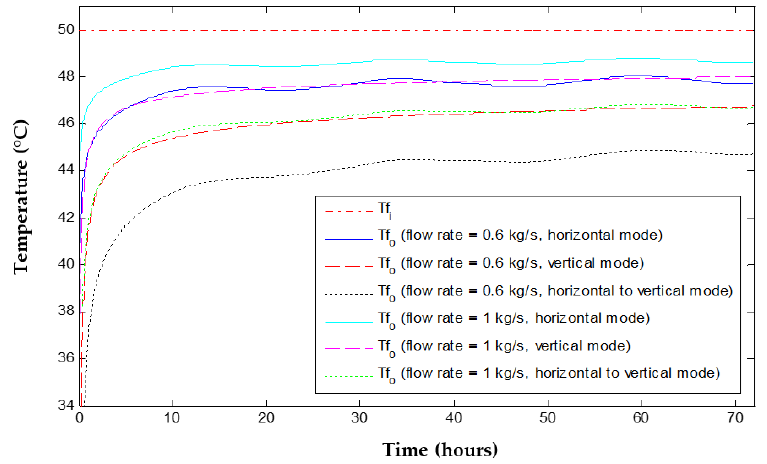
Figure 17. Profile of fluid temperature of the horizontal, vertical, and the horizontal to vertical modes with variations in the fluid mass flow rates, in Adelaide.